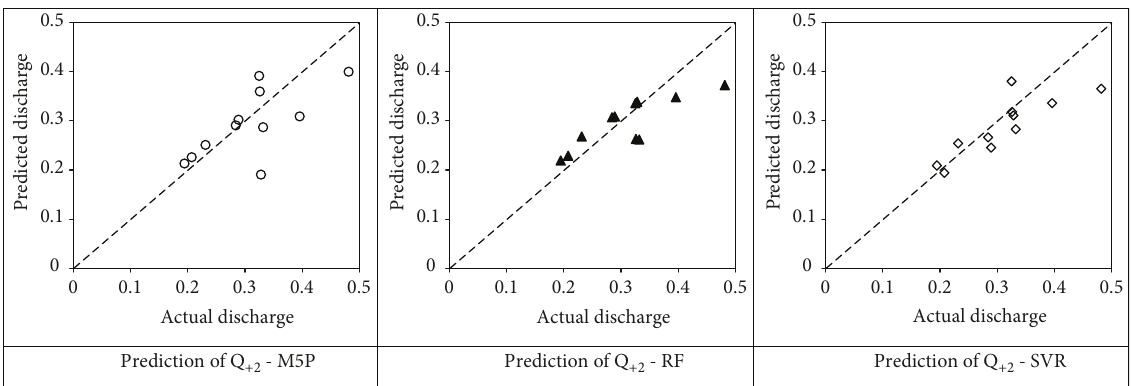
Prediction of Q + 2 - M5P Prediction of Q + 2 - RF Prediction of Q + 2 - Figure 13: Comparison between predicted and observed discharges (m 3 /s), 8-month